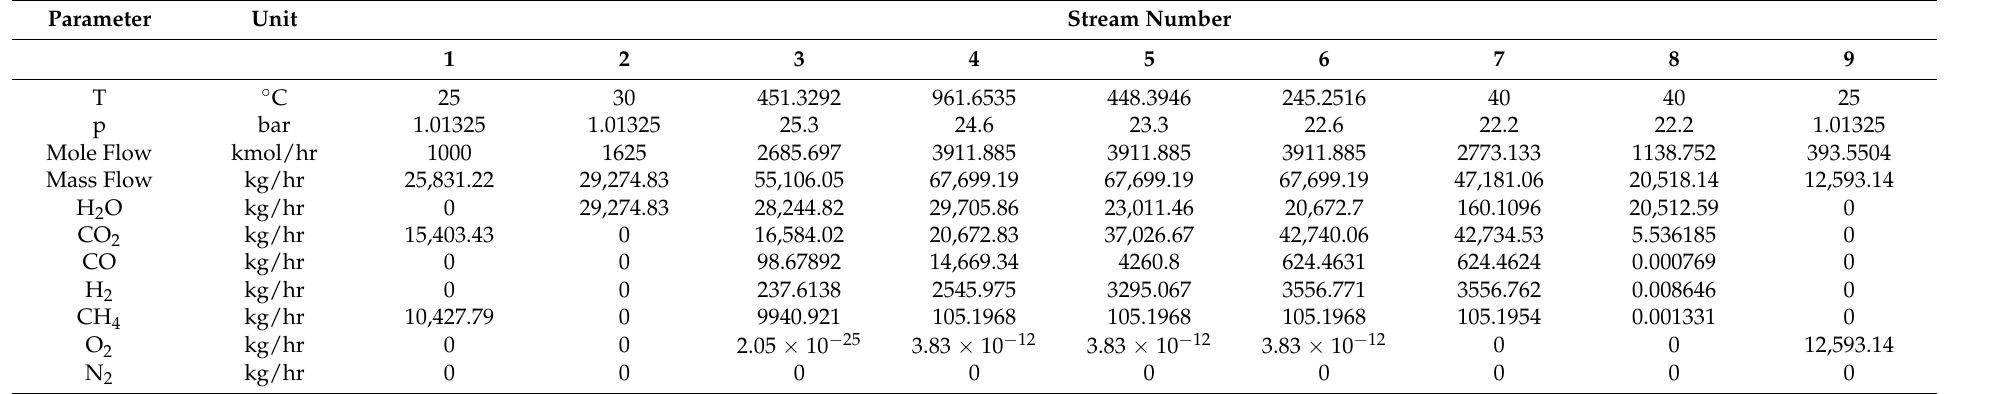
Table A3. Mass/mole flows in TRIR process with temperature and pressure state.